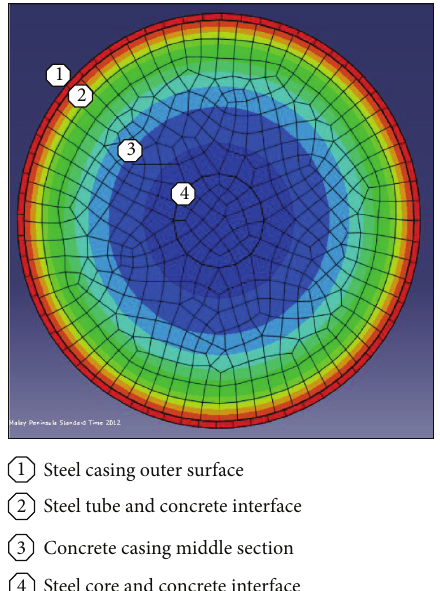
Figure 7: Different locations of bracing elements for temperature predictions.